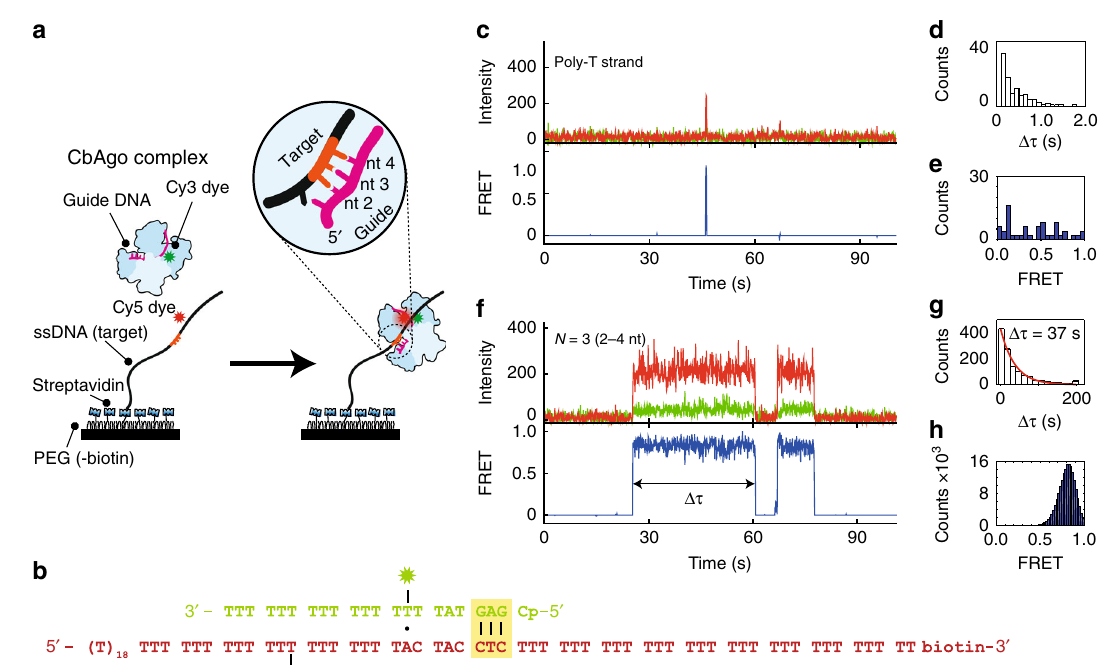
Fig. 1 Single molecule imaging of target binding by siDNA: Cb Ago complex. a Immobilization scheme of the Argonaute-guide DNA complex. ssDNA is immobilized on a PEGylated quartz slide surface. Presence of the Ago-siDNA complex is detected by speci fi c binding to target site (light yellow) resulting in high FRET. b Sequences of guide (green) and target DNA (red). Guide is labelled on the 9th nucleotide position from the 5 ′ side. c Representative FRET trace of a single molecule experiment at 100 mM NaCl showing a transient interaction between Cb Ago and a poly-T strand. Time resolution is 100 ms. d Dwell time distribution of the Argonaute in absence of target motif. e FRET values of the transient interactions of d . f Representative FRET trace of a single molecule experiment showing the interaction between Cb Ago and a 2 – 4 nt ( N = 3) motif. g Dwell time distribution of N = 3 binding events with the mean dwell time of 37 s. h FRET histogram of binding events, showing a single FRET population for N = 3 at E = 0.78. Source data are provided as a Source Data fi